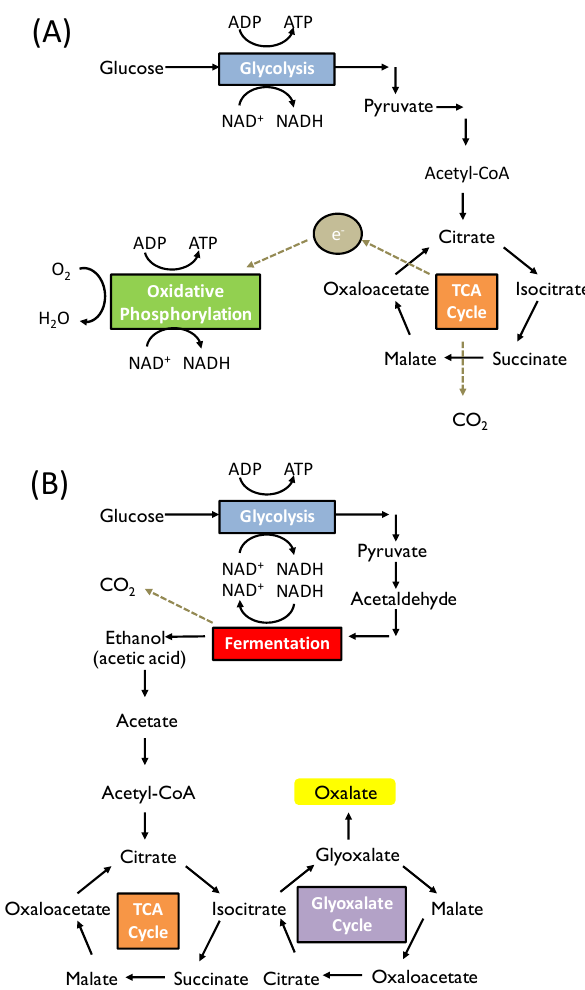
Fig. 5. (A) Conceptual representation of aerobic respiration, includ- ing glycolysis, the TCA cycle, and oxidative phosphorylation. Glu- cose is completely oxidised to CO 2 while oxygen (O 2 ) serves as the ultimate electron acceptor, being reduced to water (H 2 O). (B) In the absence of O 2 , the TCA cycle and oxidative phosphorylation be- come stalled, but glycolysis can remain active so long as NAD + is continuously resupplied via anaerobic fermentation. The products of fermentation (e.g., acetate) must be metabolised to ensure they do not have a toxic effect upon cell physiology. Here, it is proposed that acetate is ultimately metabolised to oxalate via the operation of the glyoxylate cycle – a modification of the TCA cycle (after Lu et al.,